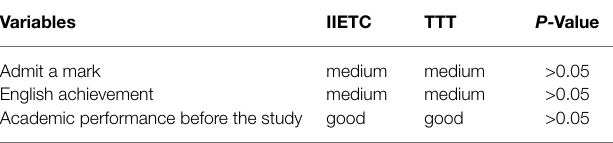
TABLE 1 | Baseline comparison before the